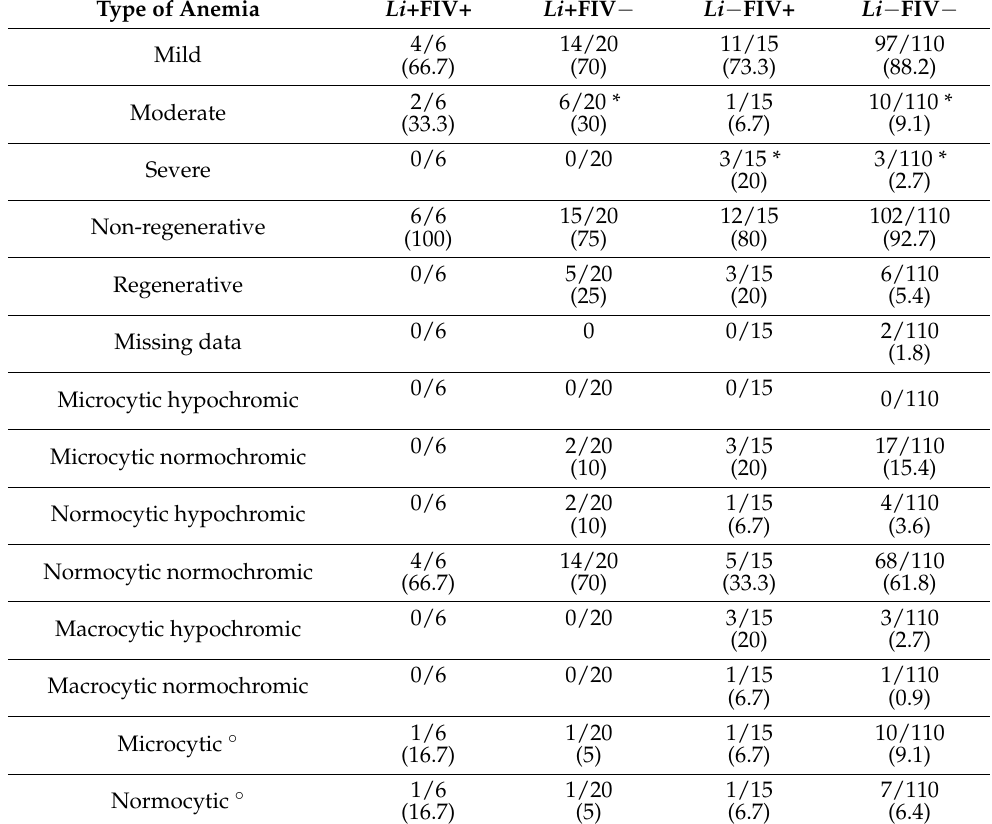
Table 6. Prevalence of different types of anemia ( n (%)) of cats classified according to their